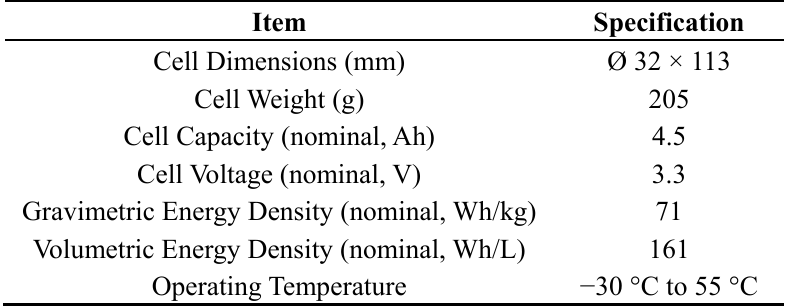
Table 2. Battery cell (LFP)